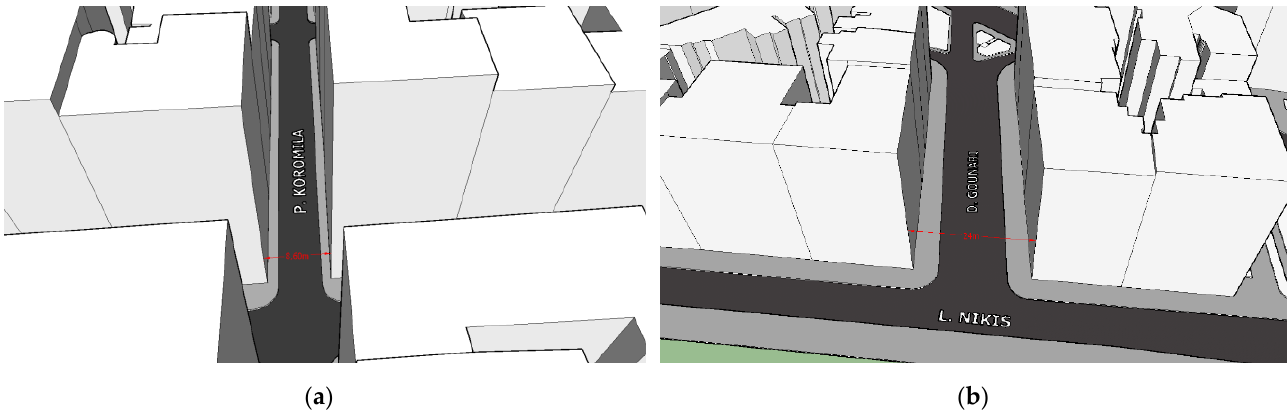
Figure 5. ( a ) Urban canyon with large width (Dim. Gounari street: 24 m.) which represents a wide urban gorge; ( b ) Urban canyon with very small width (P. Koromila street: 8.6 m.) which represents a narrow urban gorge, SketchUp software.